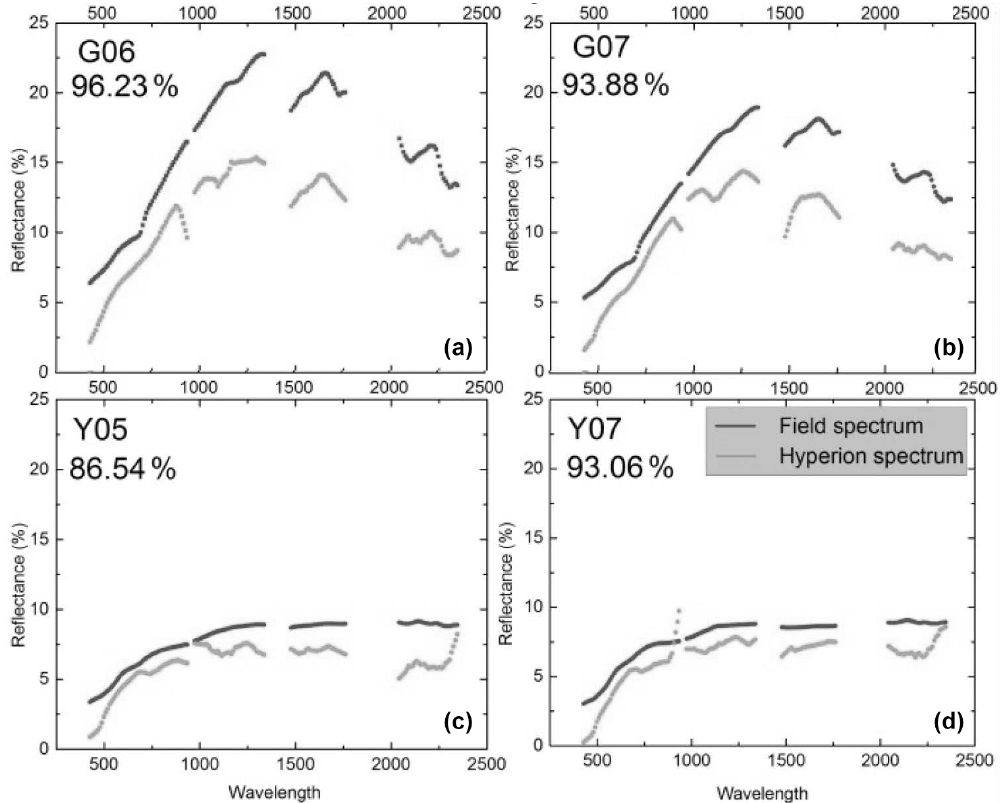
Figure 1. Reflectance spectra from the volcano Teide on Tenerife, one of the Canary Islands. The spectra were recorded on the ground (black) or remotely from satellite (gray). The percent values indicate the agreement between the black and gray curves. Top left (G06) is from a site with heavy lichen cover but no plants, and the top right (G07) is heavy lichen cover and some plants. Bottom panels show spectra of bare lava (no vegetation). From Li et al. (2015). Creative Commons Attribution License (http://creativecommons.org/licenses/by/4.0/, last access: 8 February 2022).